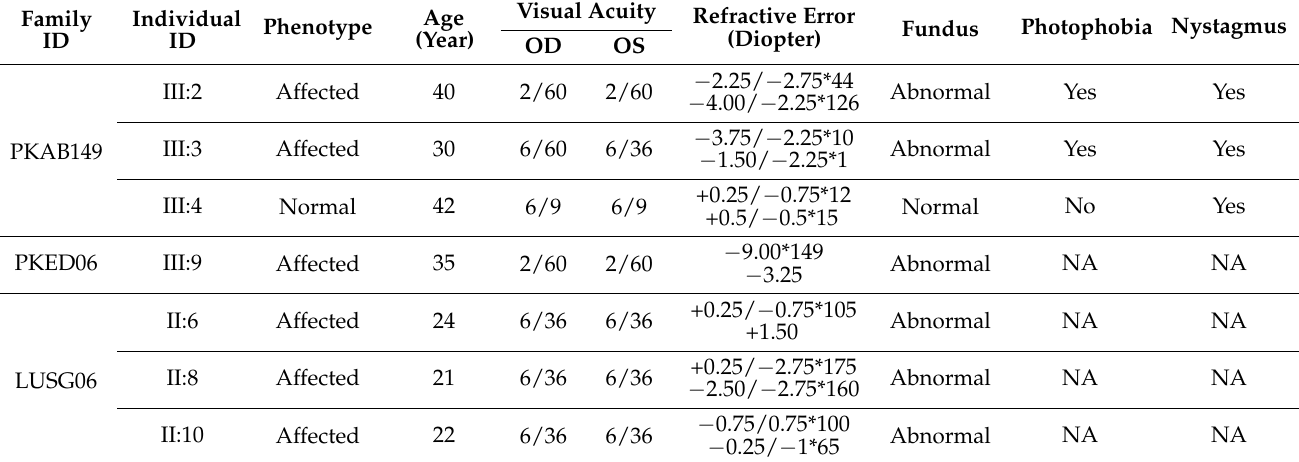
Table 1. Clinical findings of Pakistani families segregating recessively inherited achromatopsia.